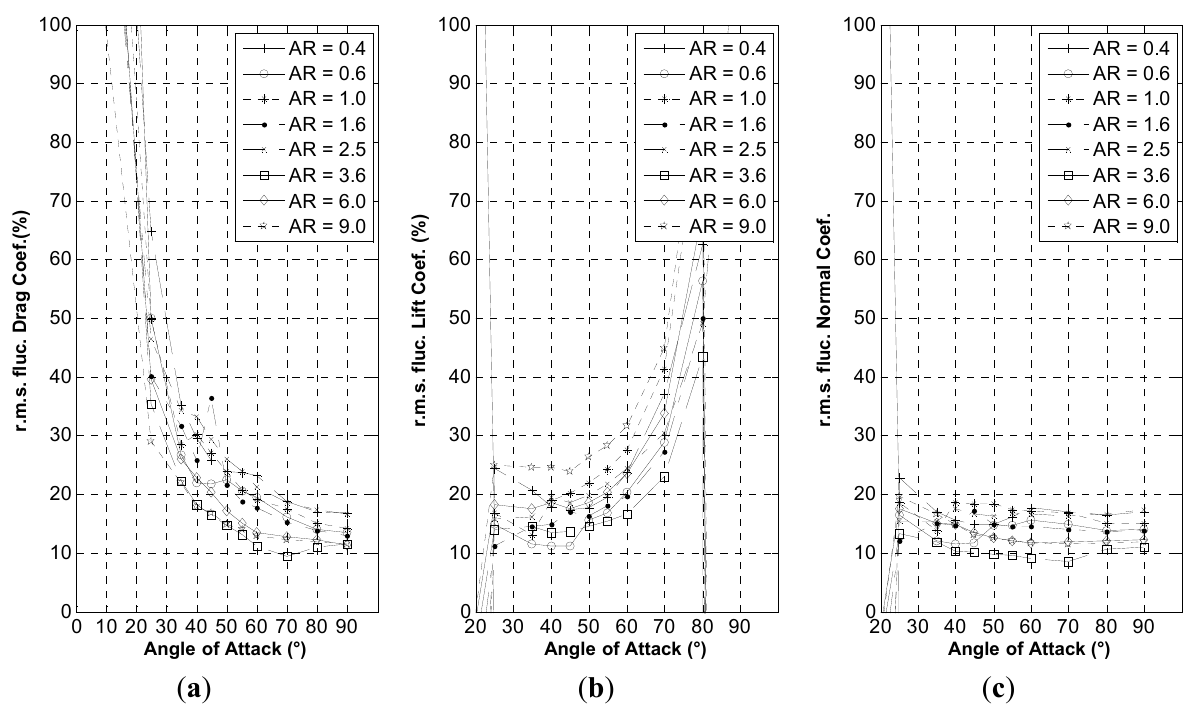
Figure 11. Root mean square fluctuation levels for ( a ) drag; ( b ) lift and ( c ) normal force in the free-stream.